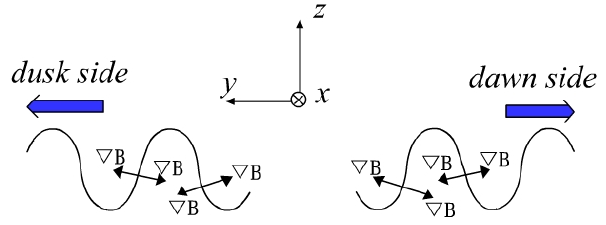
Fig. 6. Illustration of the propagation of the flapping waves of the Fig.6 Illustration of the propagation of the flapping waves of the tail tilted current tail tilted current sheet